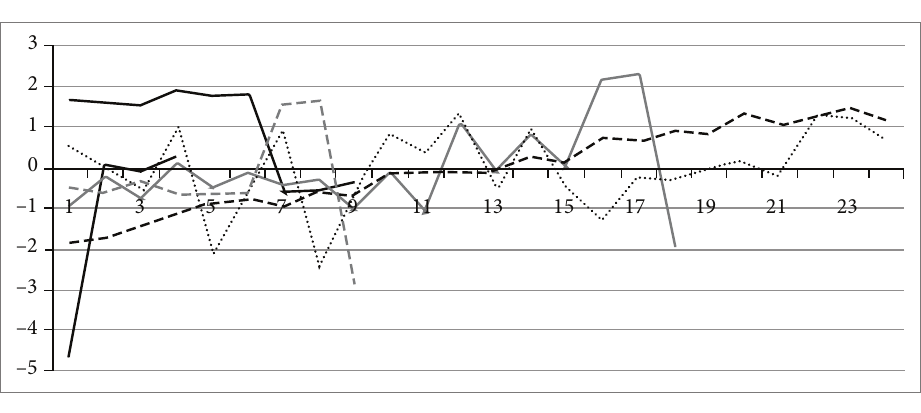
Fig. 4. Example of normalized